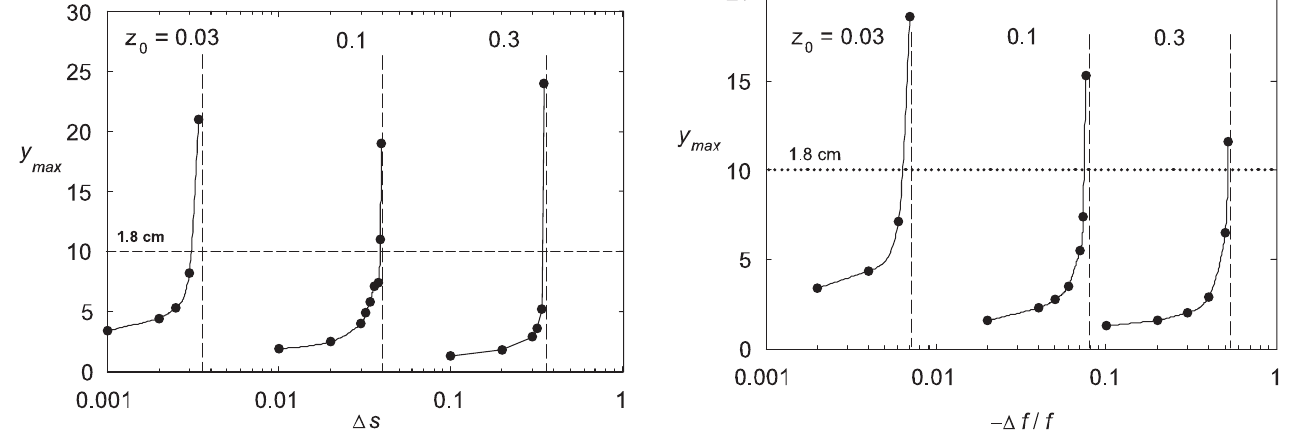
for fractional focal length max . 0 diverges where max (cid:5) (ver- = (cid:3) 1 (cid:6) 4 z 2 0 0